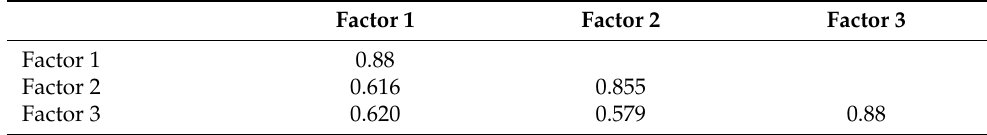
Table 6. Correlation matrix among factors of